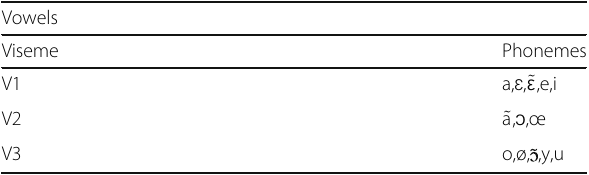
Table 1 Three visemes of